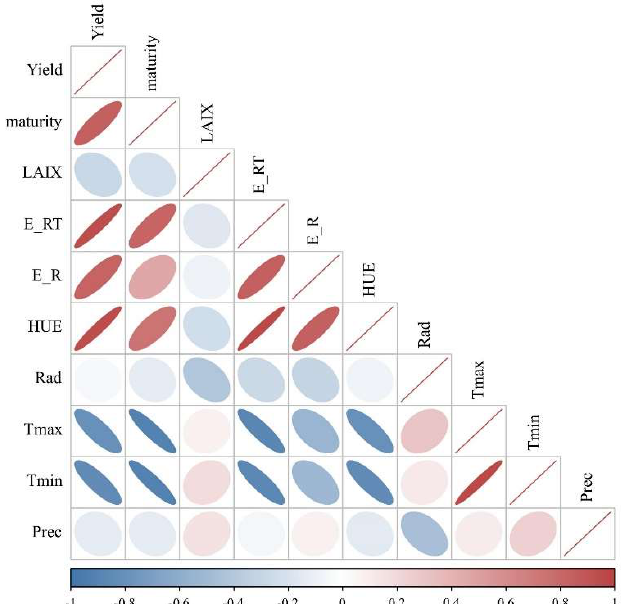
Figure 6. Correlations between the projected rice yield, maturity, maximum leaf area index (LAIX), the light and heat resource utilization indices (including E RT , E R , and HUE), and climate indices (including Rad, T max , T min , and Prec). The gradient of legend color is the function of strength of the correlation; the color and the size of ellipse indicates the strength of the correlation. Compared with the baseline of 2000–2019, in the 2040s, 2060s, and 2080s, the multi- model mean changes in rice yield were +1.90%, +4.68%, and +2.46% under SSP126, respec- tively, and +0.25%, +0.48%, and +0.80% under SSP245, respectively, and −1.60%, −3.80%, and −24.89% under SSSP585, respectively (Figure 7). In general, rice yield varied incon- sistently under different future scenarios, with a slight increase under SSP126 and SSP245 and a significant downward trend under SSP585. The result showed the greatest reduction in rice yield in the 2080s under SSP585. We used stepwise multiple linear regression anal- ysis to reflect the relationship between rice yield and climatic variables change (including mean temperature, precipitation, and solar radiation). The value of the determination co- efficient (R 2 ) was 0.717. As the regression coefficient was shown in Table 3, rice yield was significantly positively correlated with solar radiation and negatively correlated with mean temperature, while rice yield had a slight positive correlation with precipitation. In addition, temperature, precipitation, and solar radiation could explain 71.7% of the rice yield change.